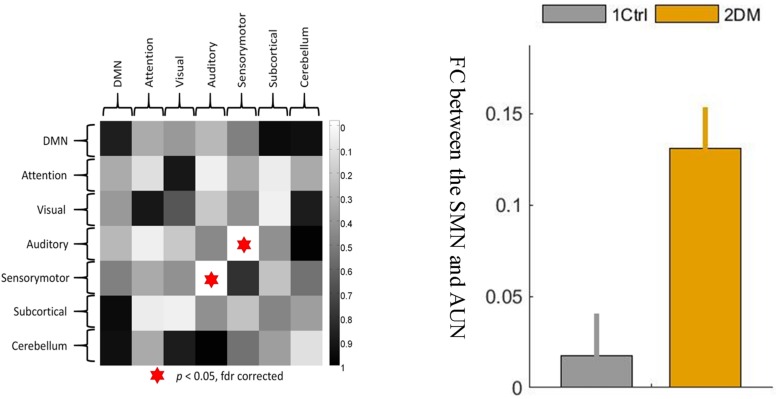
The between-network connectivity strengths between the sensory-motor network and the auditory network were significantly greater at the network level in the T2D group than in the control group. 1 ctrl: the first group is the control group; 2 DM: the second group is the type 2 diabetes group. The error bars in the figures represent the variance.